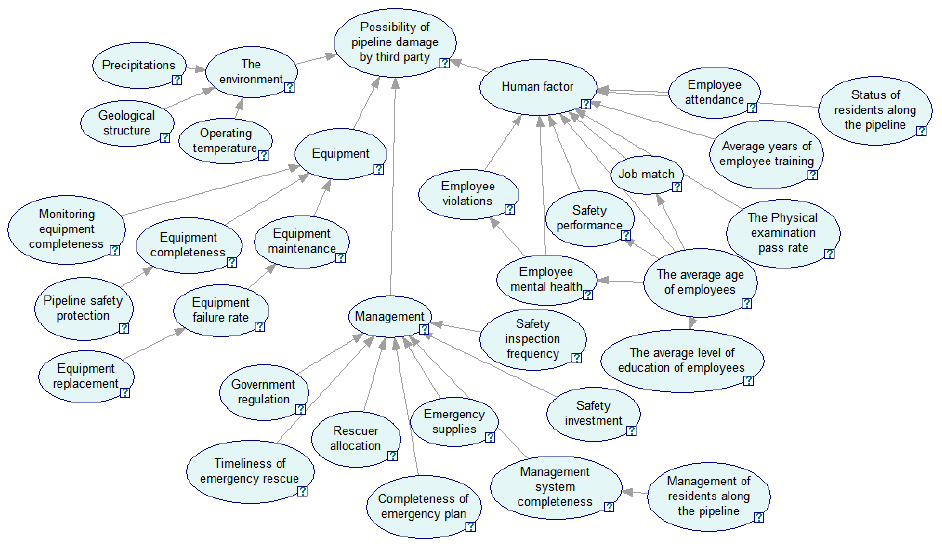
Figure 2. Initial Bayesian network diagram.